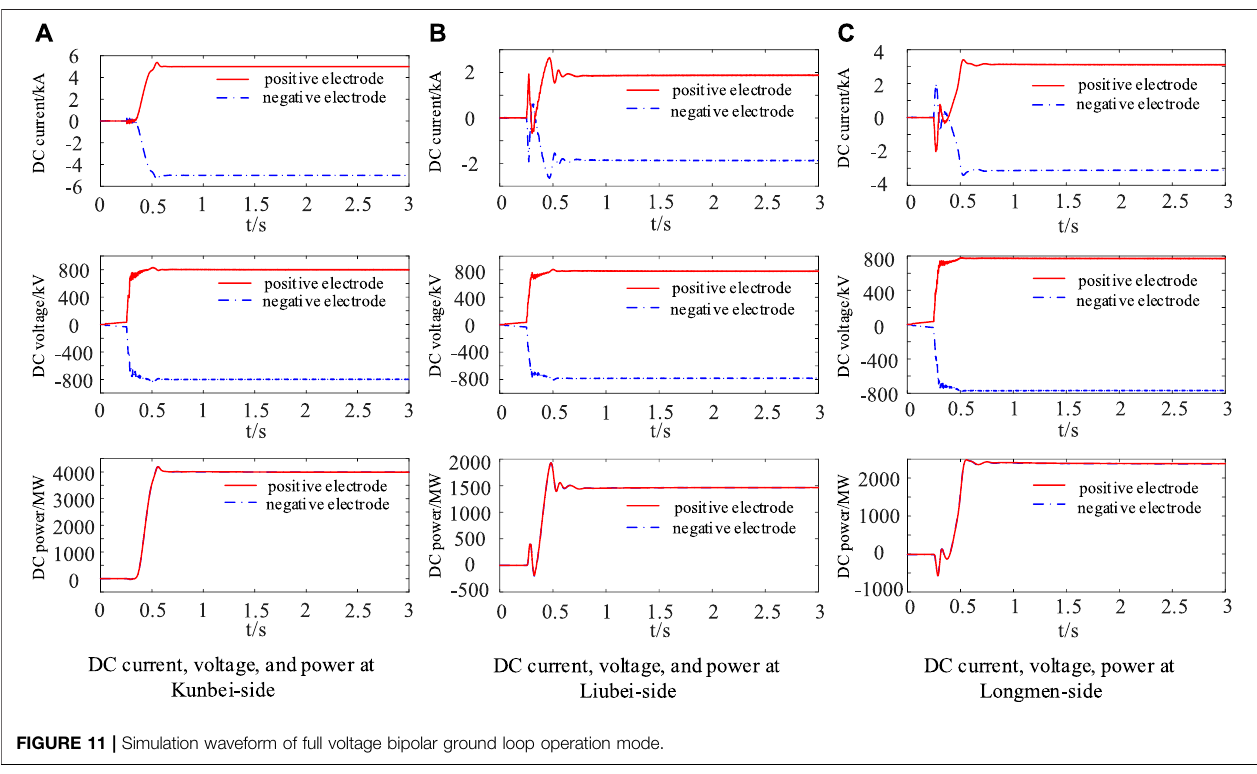
FIGURE 11 | Simulation waveform of full voltage bipolar ground loop operation mode.